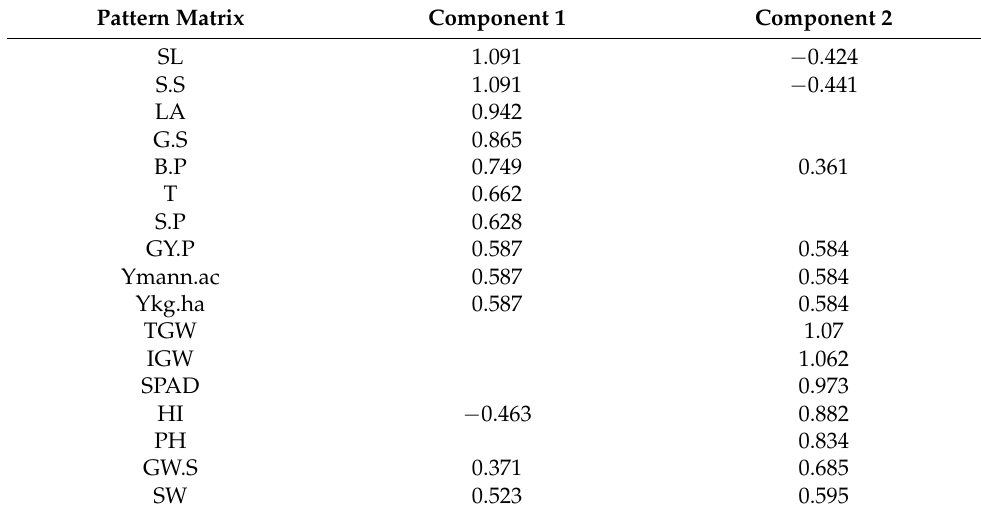
Table 3. Principal component analysis between morphology and abiotic stress responses.